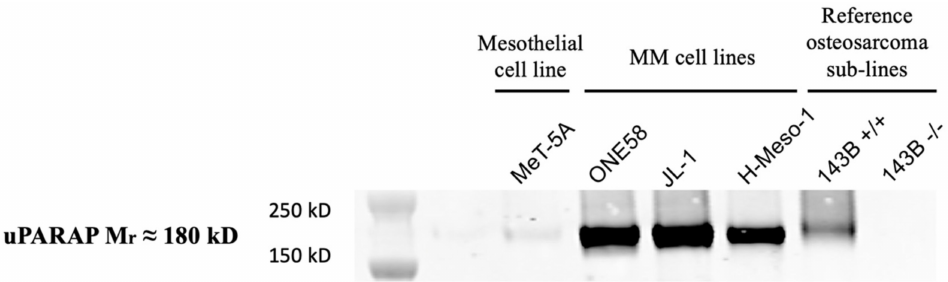
Figure 4. Expression of uPARAP in various cell lines. The relative expression was assessed by western blot in a non-malignant human mesothelial cell line (MeT-5A), human mesothelioma cell lines (ONE58, JL-1, H-Meso-1) and positive and negative control cells (osteosarcoma cell lines 143B +/+ and 143B -/-; see text). Bands of apparent 180 kD molecular mass indicate expression of uPARAP in all of the cancer cell lines except for the negative control. Very low expression levels were observed in MeT-5A. Comparable loading of total protein was confirmed by Coomassie ® blue staining of residual protein in the SDS gel, left after electroblotting (Figure